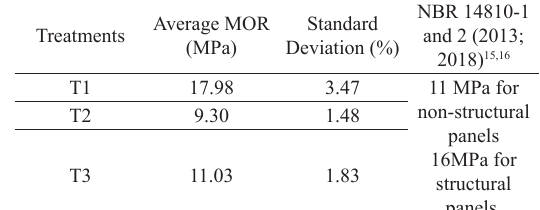
Table 6. Average modulus of rupture and